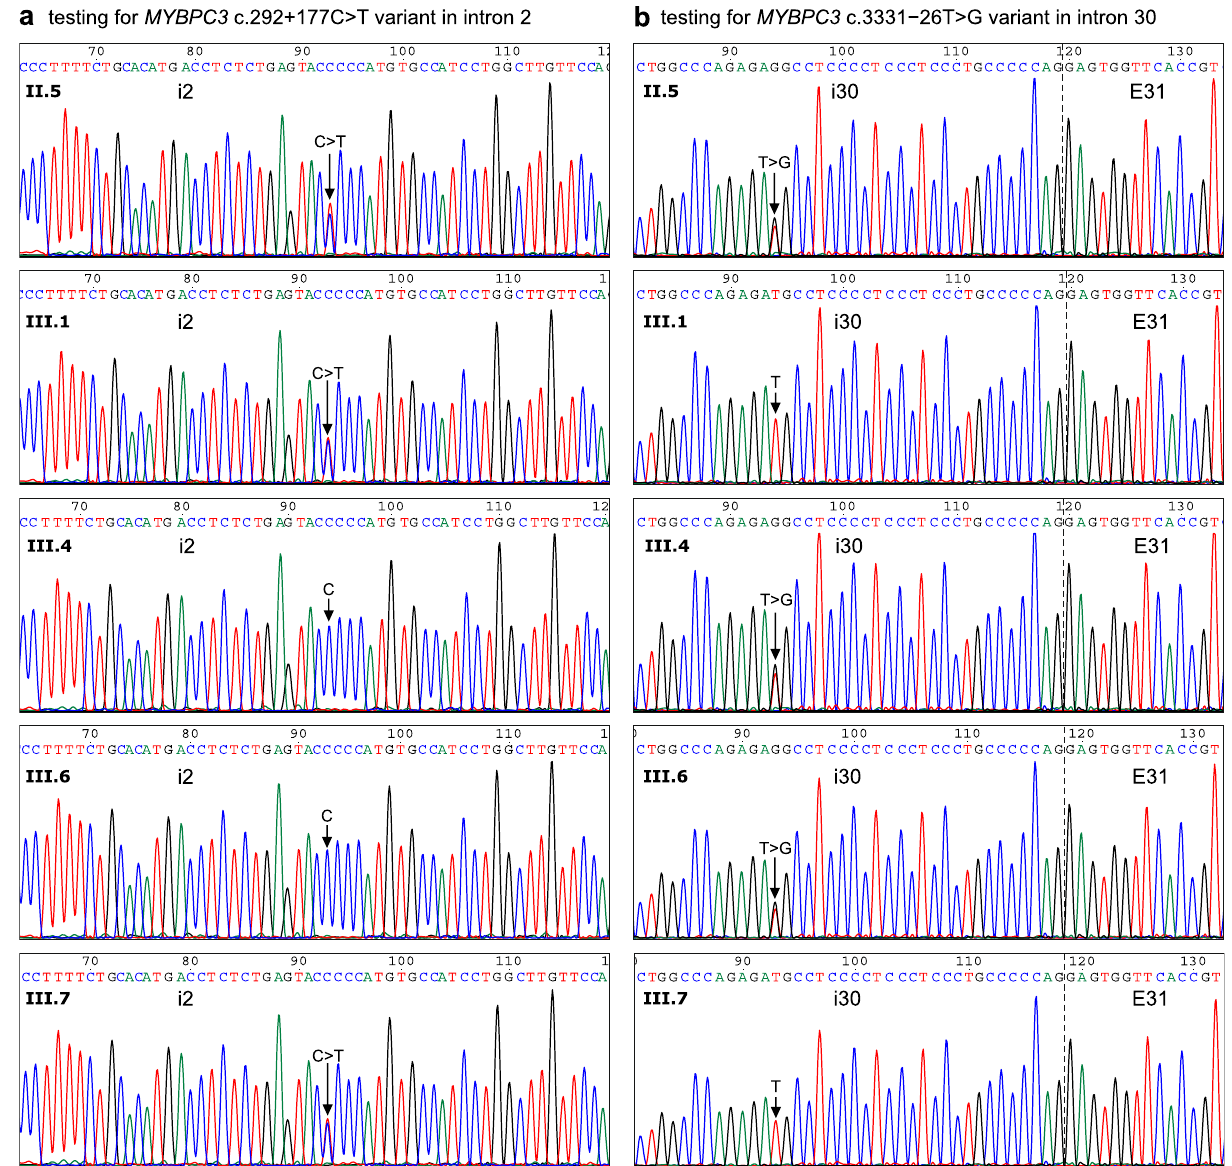
Figure 2. Family inheritance analysis of two rare intronic MYBPC3 variants identified in the index patient. Sanger DNA chromatograms testing the MYBPC3 c.292+177C>T variant in intron 2 ( a ) and the MYBPC3 c.3311−26T>G variant in intron 30 ( b ) are shown. DNA chromatograms from the index patient (II.5) revealed the presence of both nucleotide substitutions in the heterozygous state, thus independently confirming the massively parallel sequencing results (see Supplementary Fig. S1). Sequence analyses of four family members of the III generation are also shown: one index patient’s son (III.1) and three daughters (III.4, III.6 and III.7). Two of them inherited from their mother the MYBPC3 variant in intron 2 (III.1, III.7) and the other two (III.4, III6) the MYBPC3 variant in intron 30. The complete family testing results are presented in Fig. 1. Arrows indicate the position of the affected nucleotide. The intron–exon boundary (i30-E31) is marked with a dotted